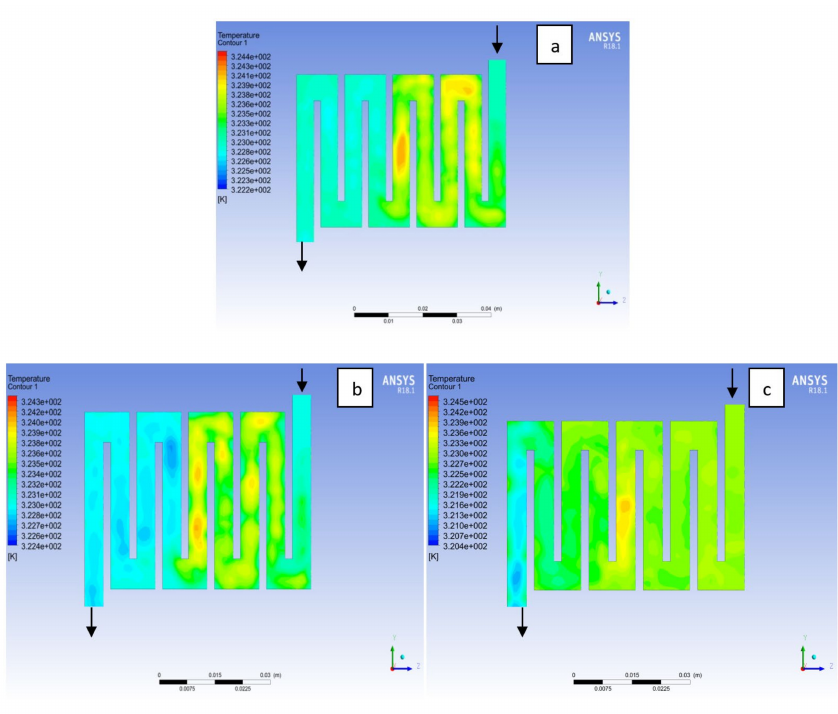
Figure 7. Temperature distribution at the cathode region (GDL/CL) for each material at 323K: ( a ) Aluminum, ( b ) Copper, ( c ) Steel.